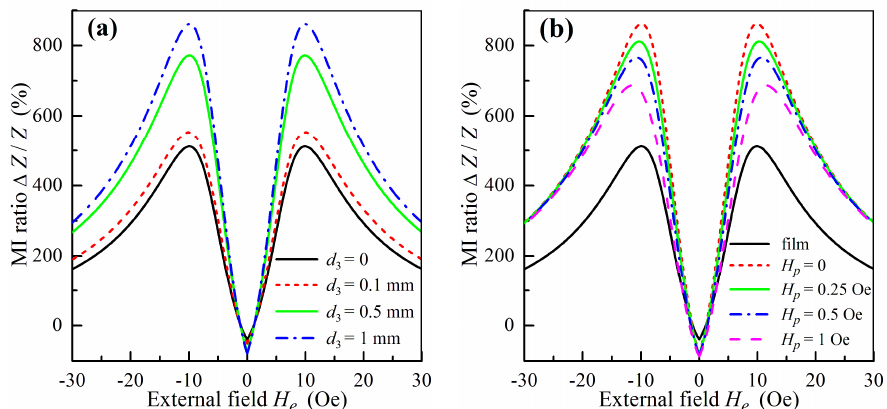
Figure 8. MI ratio Δ Z / Z as a function of the external field H e for gel at f = ω / 2 π = 100 MHz and different values of the ferrogel layer thickness d 3 ( a ). MI ratio ∆ Z / Z as a function of the external field H e for ferrogel at f = 100 MHz and different values of the effective stray field H p . The parameters of the ferrogel layer are d 3 = 1 mm, H c = 4 Oe and H 1 = 750 Oe ( b ). Parameters used for calculations are l = 1 cm, w = 0.01 cm, 2 d 0 = 500 nm, d 1 = 5 nm, d 2 = 100 nm, n = 4, M = 750 G, H a = 7.5 Oe, ψ = − 0.05 π , σ 1 = 5 × 10 17 s − 1 , σ 2 = 4 × 10 16 s − 1 , κ = 0.02 and ε = 70.